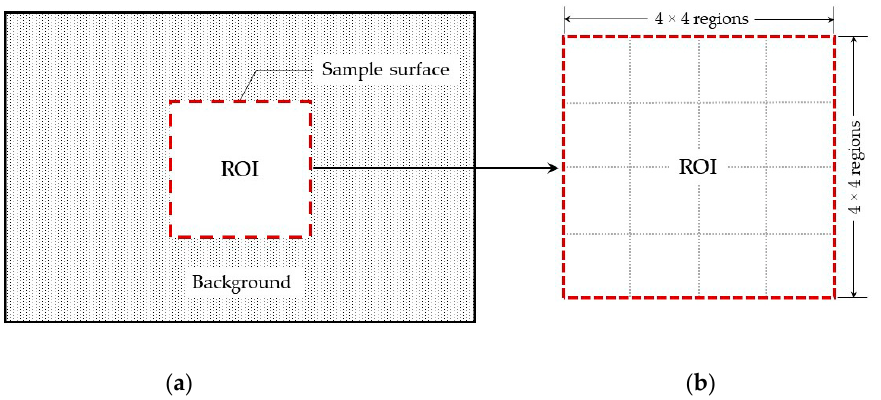
Figure 4. Selections of the region of interest (ROI): ( a ) ROI extracted from the background; ( b ) ROI divided into 4 × 4 regions.